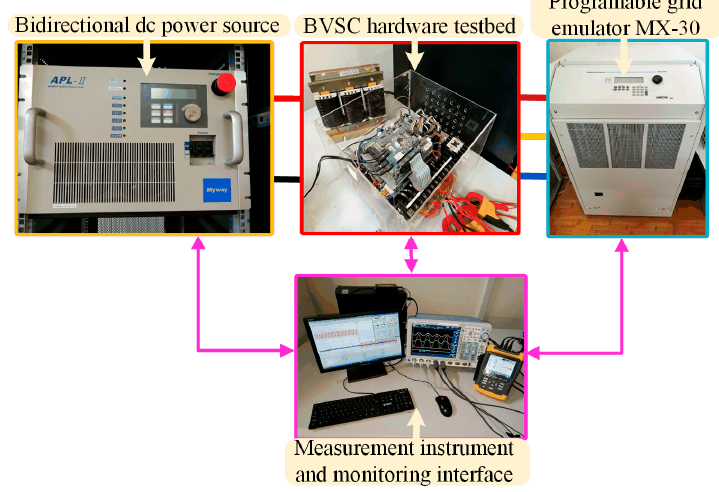
Figure 11. Experimental setup of fault-tolerant BVSC.